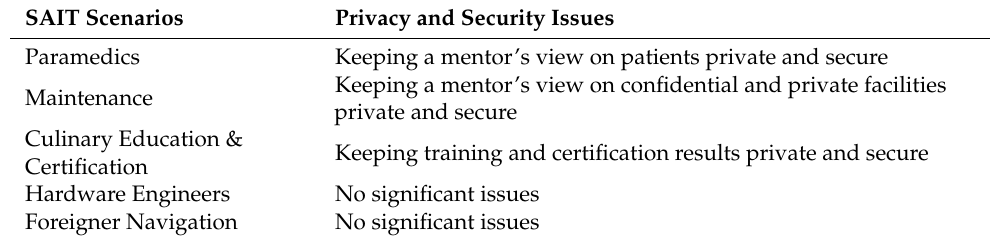
Table 8. Privacy and security issues in SAIT scenarios.